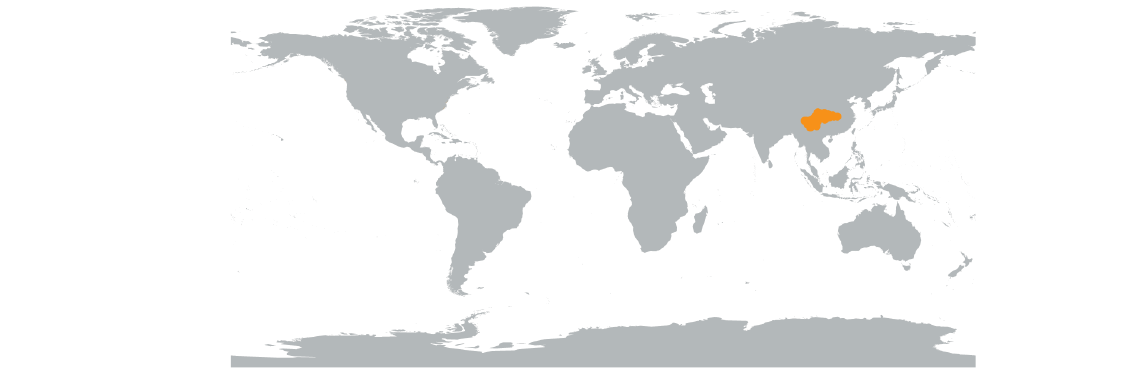
Fig. 43. Distribution of Malus yunnanensis (Franch.)